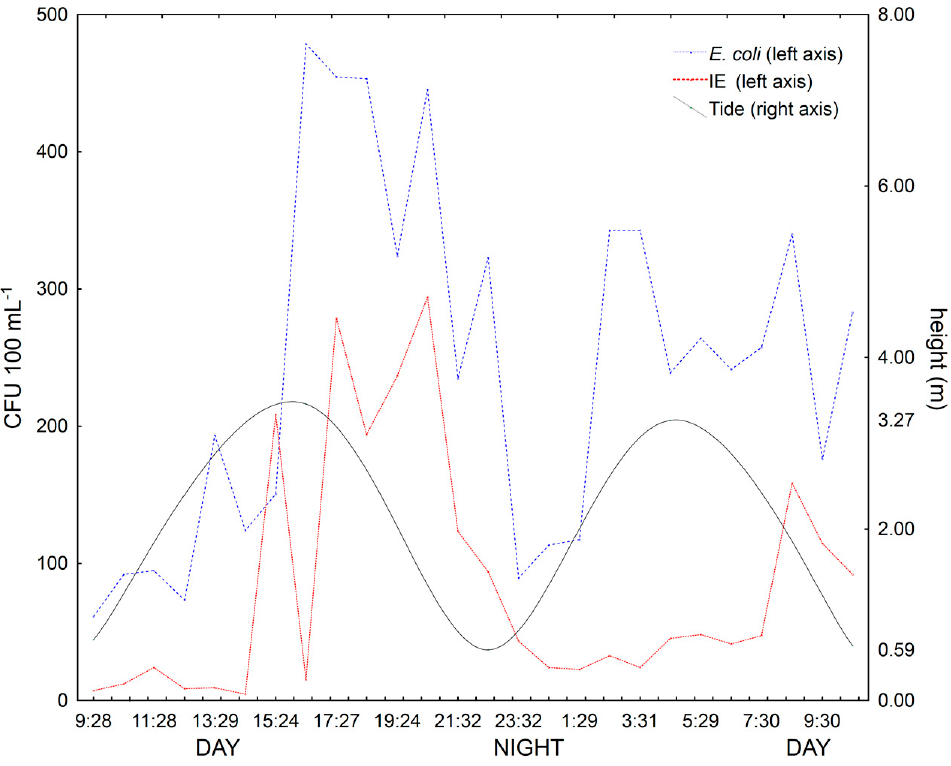
Figure 4. Hourly variability of the tidal height during two consecutive tidal cycles (m) and the distribution of E. coli and intestinal enterococci (IE) (cfu 100 mL − 1 ) at Zebreiros beach (20–21 July 2016).